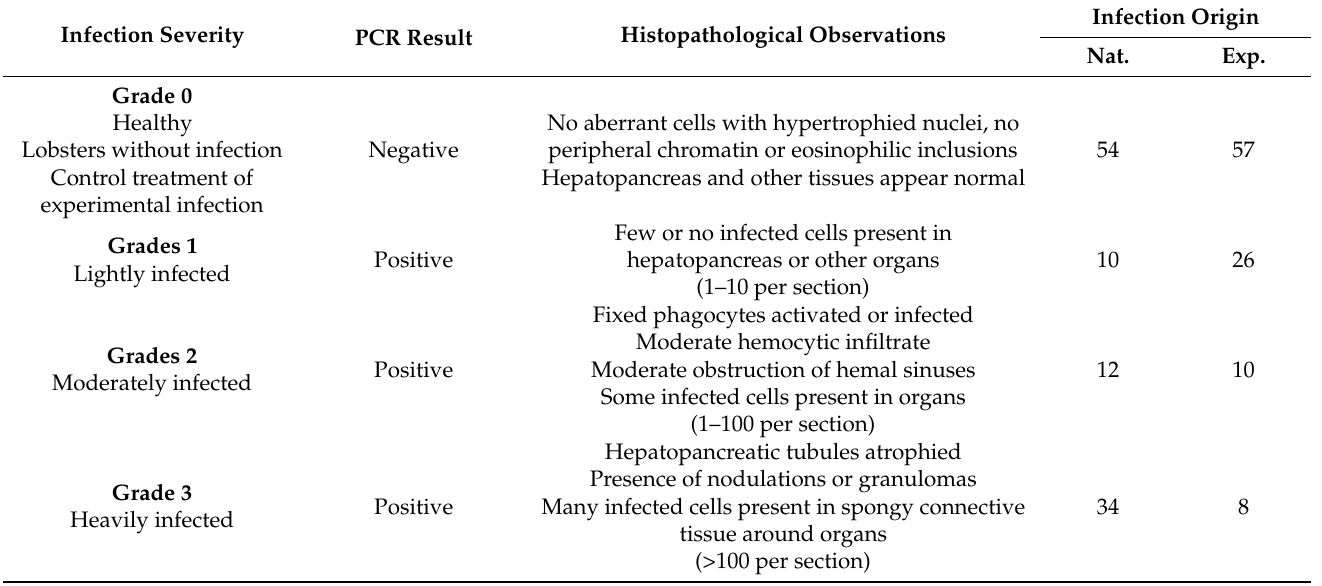
Table 1. Grades of severity of Panulirus argus virus 1 (PaV1) infection in Panulirus argus lobsters according to Li et al. [17] and Pascual et al. [25]. Number of organisms in each degree of severity by infection origin: natural (Nat.), and experimental